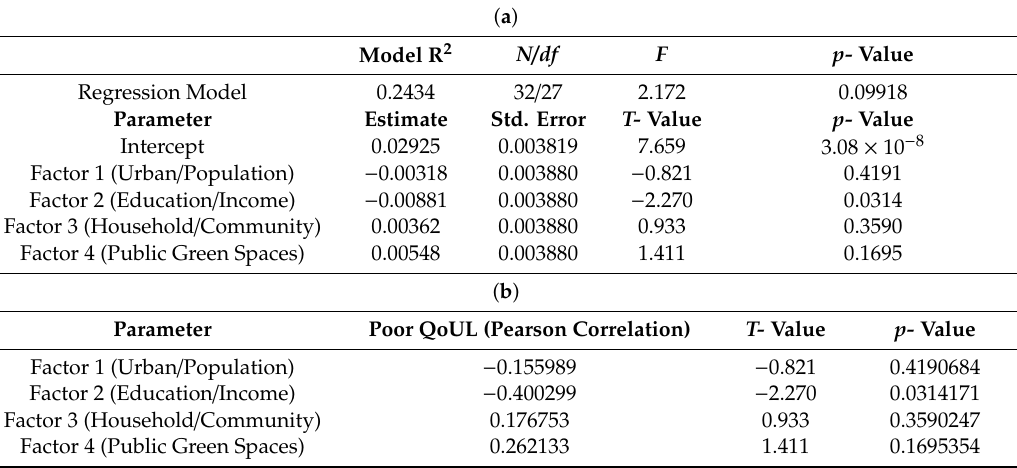
Table 8. Multiple Regression and Partial Correlations for Poor QoUL. ( a ) Results of the multiple regression analysis predicting poor QoUL from the four factor components. ( b ) Results of the partial correlation analysis predicting poor QoUL from the four factor components.